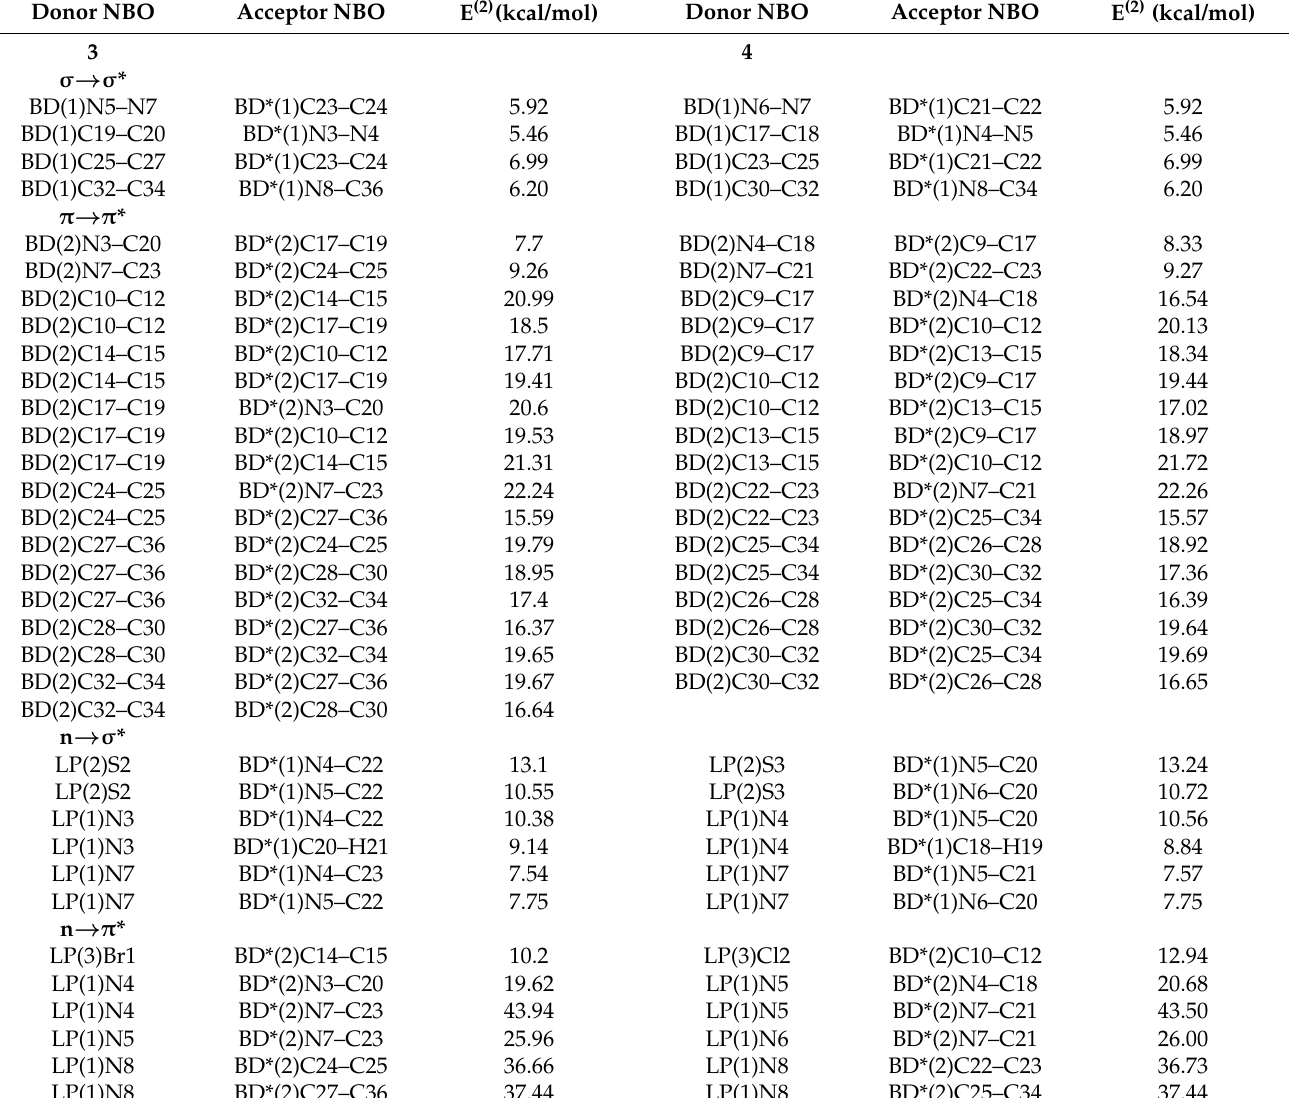
Table 8. The E (2) (kcal/mol) values for the IMCTprocesses in 3 and 4 a